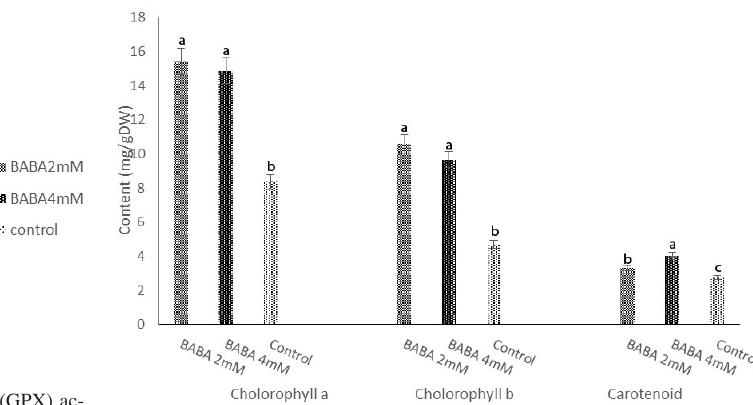
Fig. 9: The Mean comparisons of chlorophyll a and b, and carotenoid con- tent of control and Primed inoculated cucurbit plants with 4 mM BABA at 240 hours post inoculation. Standard bar showed diffe- rences at α = 0.5%.